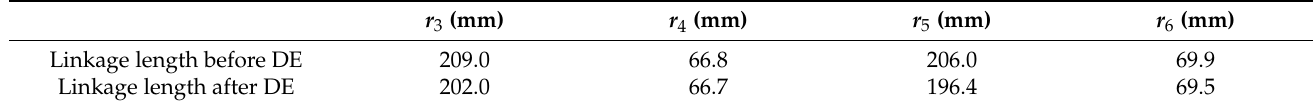
Table 2. Linkage lengths before/after DE